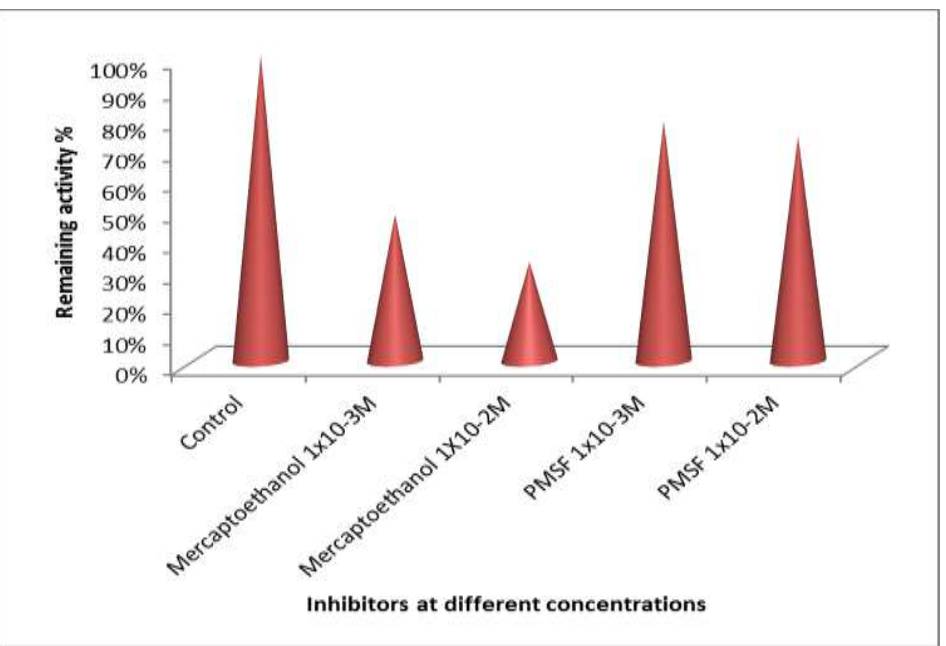
Figure 6: Effect of inhibitors on the remaining activity of